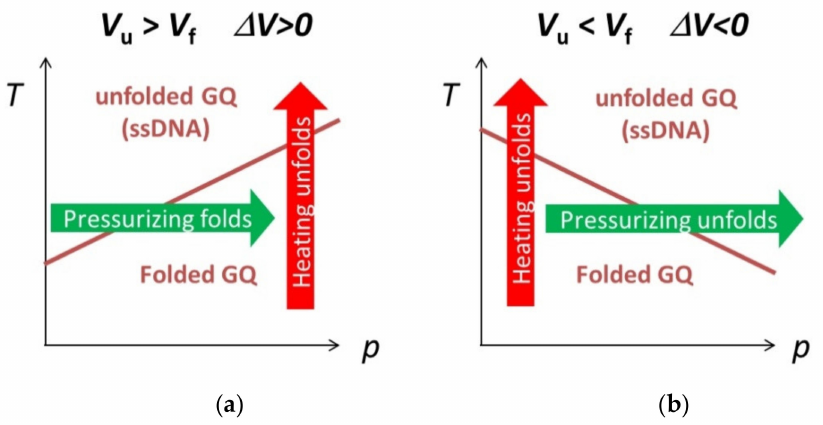
Scheme 1. Shape of the temperature–pressure phase diagram, in the cases of different signs of the unfolding volume ∆ V . ( a ) ∆ V > 0 and ( b ) ∆ V < 0. V f and V u are the volumes of the folded